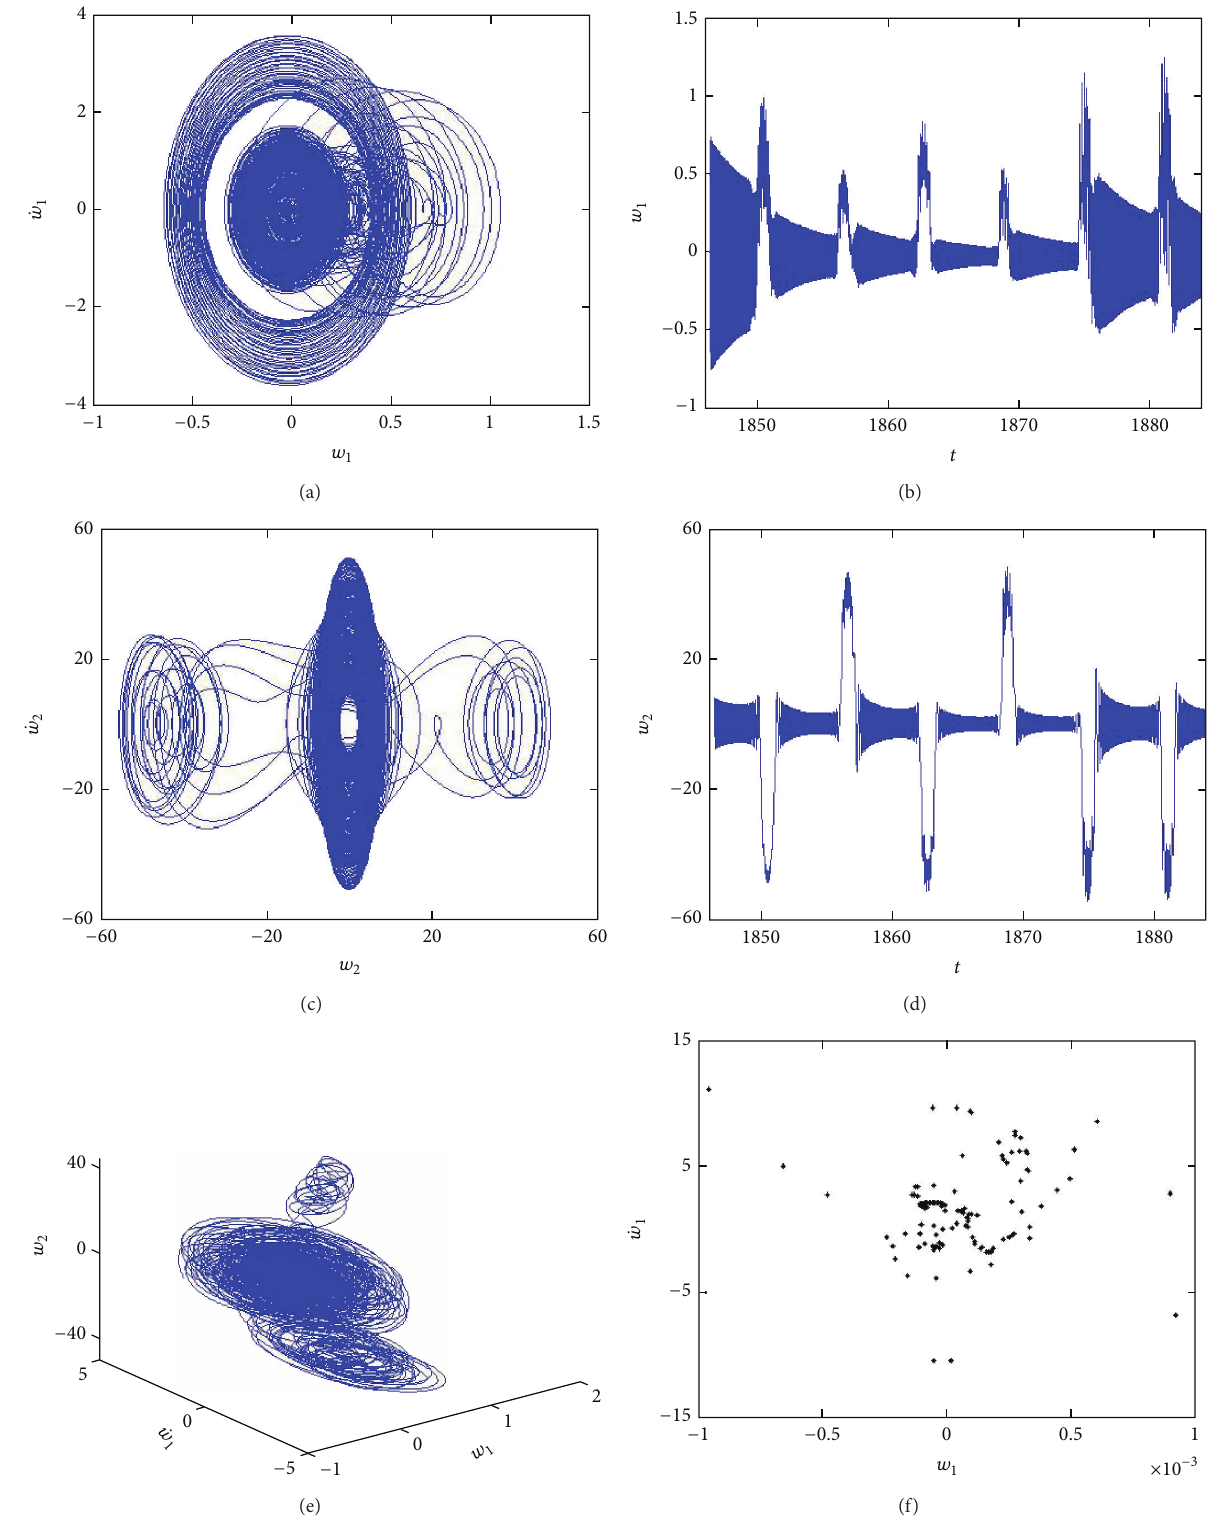
Figure 8: The chaotic motion of the FGM cylindrical panel occurs when the magnitude of the in-plane excitation is taken to be 7.79 × 10 7 . The volume fraction index is taken to be 0.5. The Mach number is taken to be